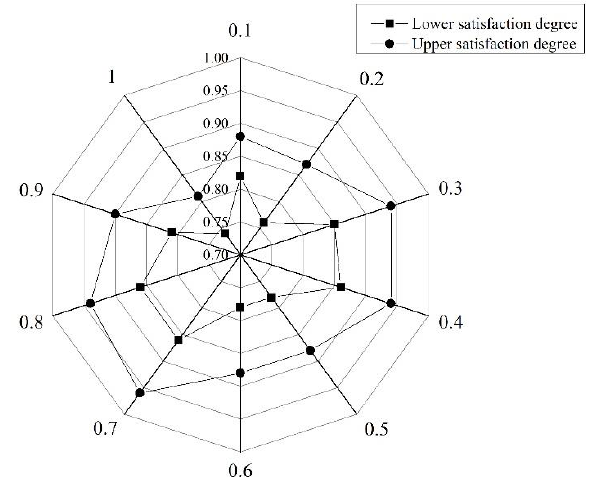
Figure 5 . Illustration of the relationship between satisfaction degrees and confidence levels . Figure 5. Illustration of the relationship between satisfaction degrees and confidence